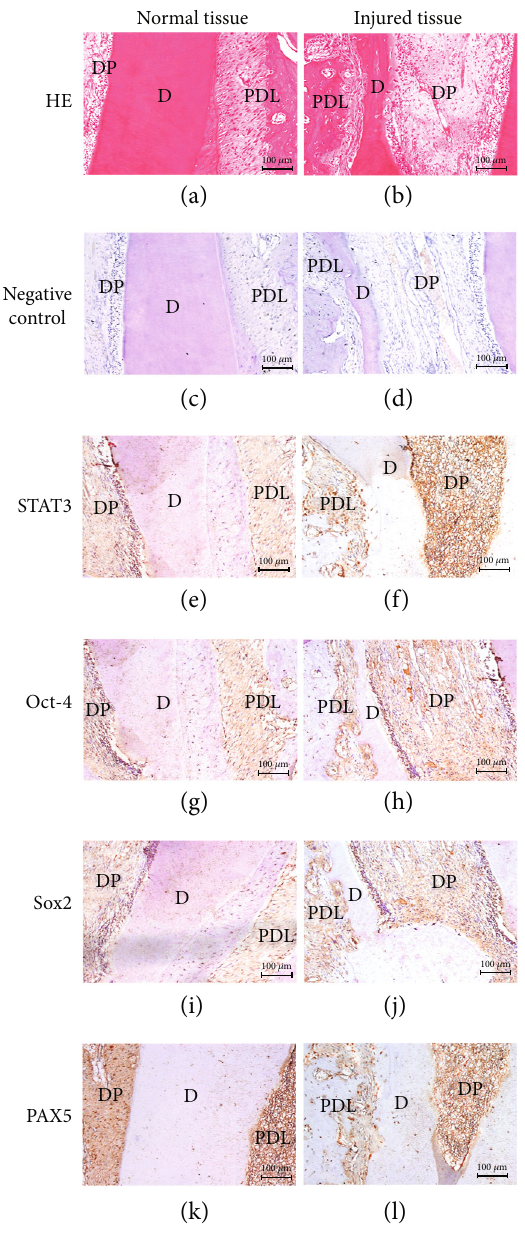
Figure 5: Expression and distribution of stem cell-related markers in the rat defect models. Hematoxylin and eosin staining revealed the structures of the normal and injury groups (a, b). The primary antibody was replaced by PBS in the negative control groups of normal and injury groups (c, d). STAT3, Oct-4, and Sox2 were notably present in the nucleus and, to a lesser extent, in the cytoplasm of the injury groups (f, h, and j). Rare staining of STAT3, Oct-4, and Sox2 was found in the normal groups (e, g, and i). Intense staining of PAX5 was found in the cytoplasm and matrix around the normal dental pulp and periodontal ligament when compared with PAX5 staining in the repaired connective tissues (k). Rare staining of PAX5 was detected in the injury groups (l). Scale bars = 100 μ m . D: dentin; DP: dental pulp; PDL: periodontal